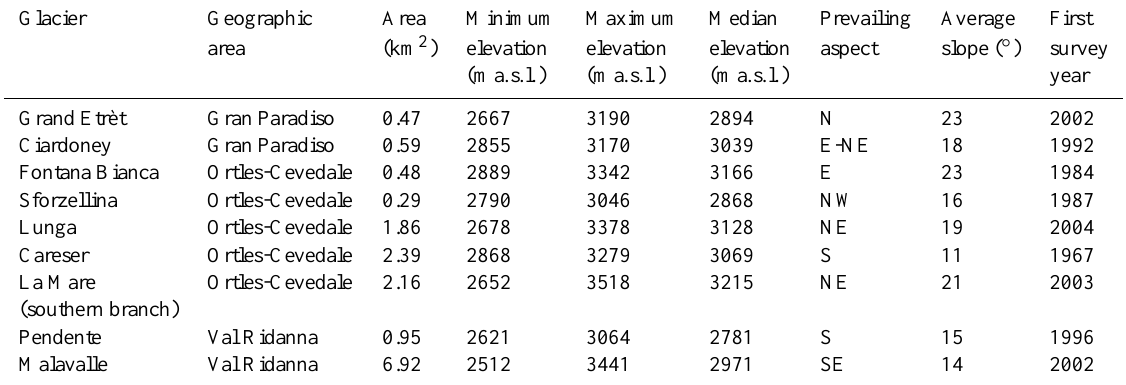
Table 1. Physical characteristics of the Italian glaciers with the mass balance series analyzed in this study (year 2006, NextData – DATA- GRALP project: http://www.nextdataproject.it/?q=en/content/special-project-datagralp, last access: 27 September 2015; Salvatore et al.,